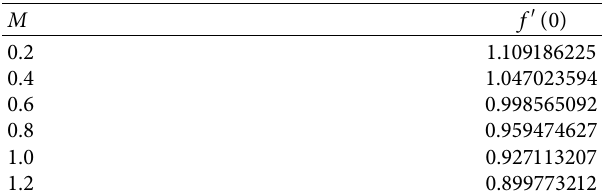
Table 2: Values of f ′ ( 0 ) for the case of prescribed heat flux at c � 0 .